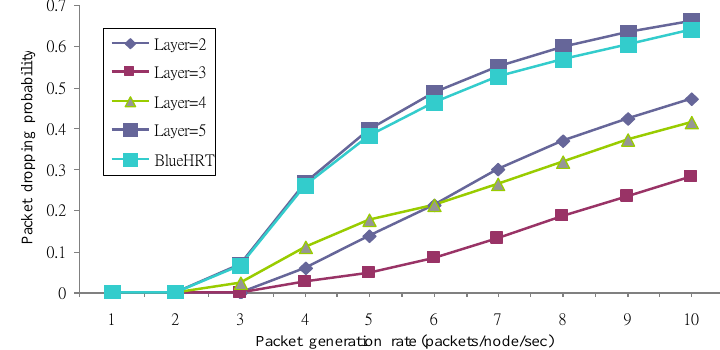
Figure 13. Packet dropping probability of mesh-tree and BlueHRT.